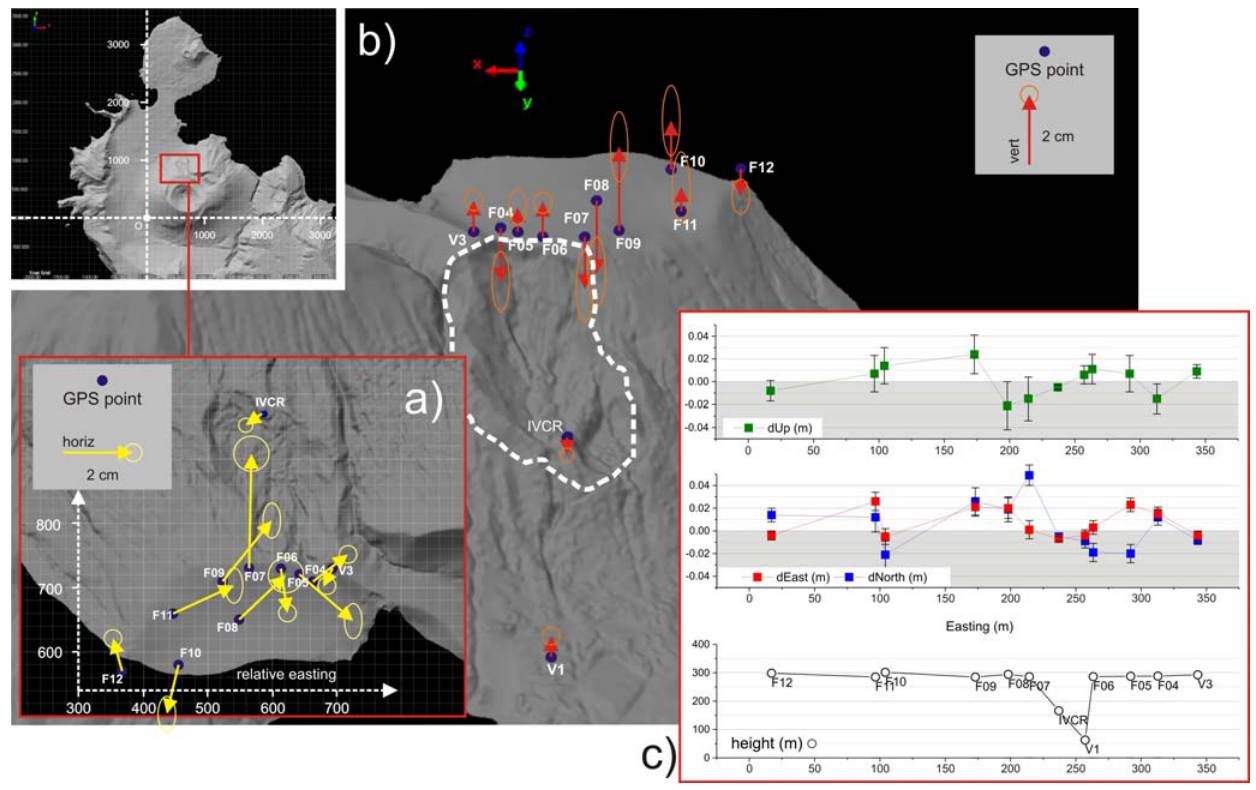
Figure 4. ( a ) Horizontal displacement and corresponding error ellipses, measured by GPS, in the landslide zone at the NW part of crater rim. The reference for the relative easting is also shown. ( b ) GPS-based vertical displacements shown on a perspective view from about N direction ( x -axis; the y -axis, therefore, is the E direction; please see the drawn reference frame). The dashed line indicates the crater rim. ( c ) Maps of vertical and horizontal GPS displacements, as a function of relative easting, compared with the EDM results. The facts that V1 and IVCR stations are unaffected by significant motions and that the displacements of benchmarks at the rim are significant instead should be